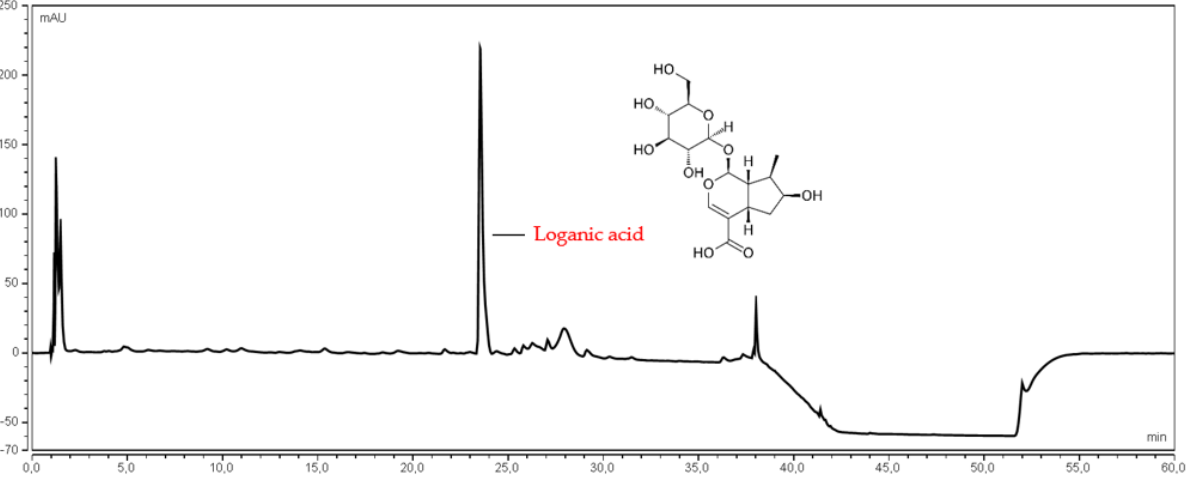
Figure 2. The chromatogram of loganic acid presented in the water extract of Corni fructus cultivar Wydubieckij .